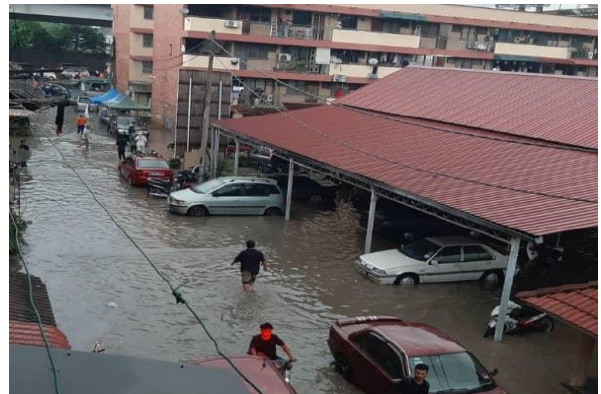
Figure 1. Pluvial flood in Kampung Baru, 1 October 2019. Due to poor drainage, water depth of 1m was reached after 2h of rain (BERNAMA,